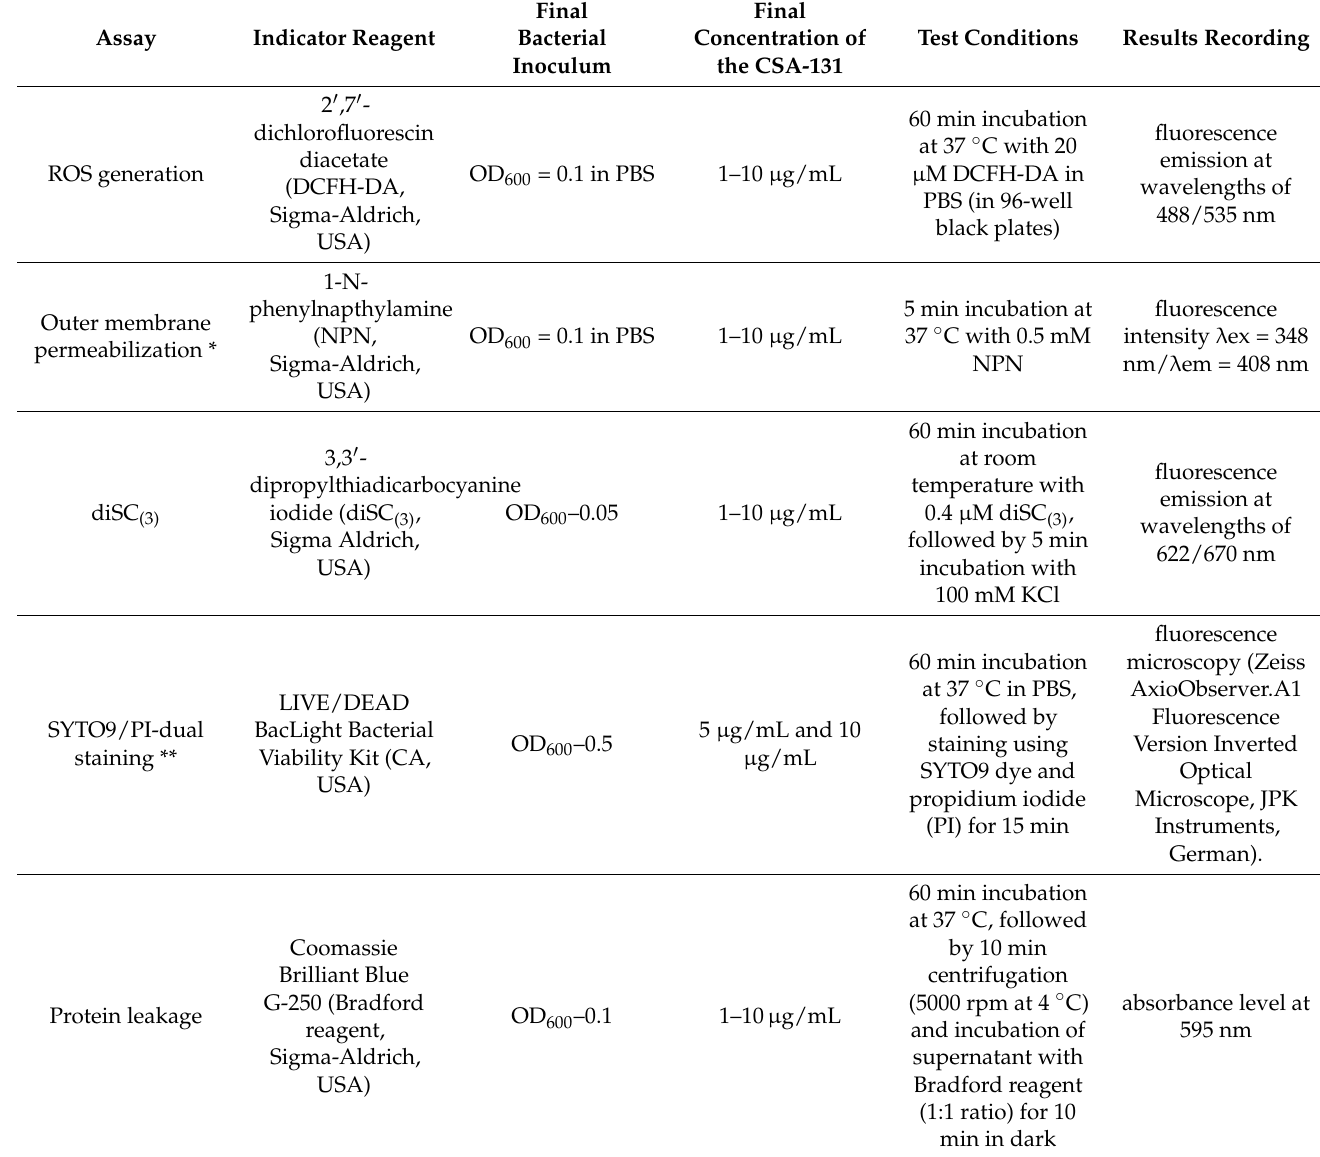
Table 5. Assays used for the analysis of the bacterial response to the